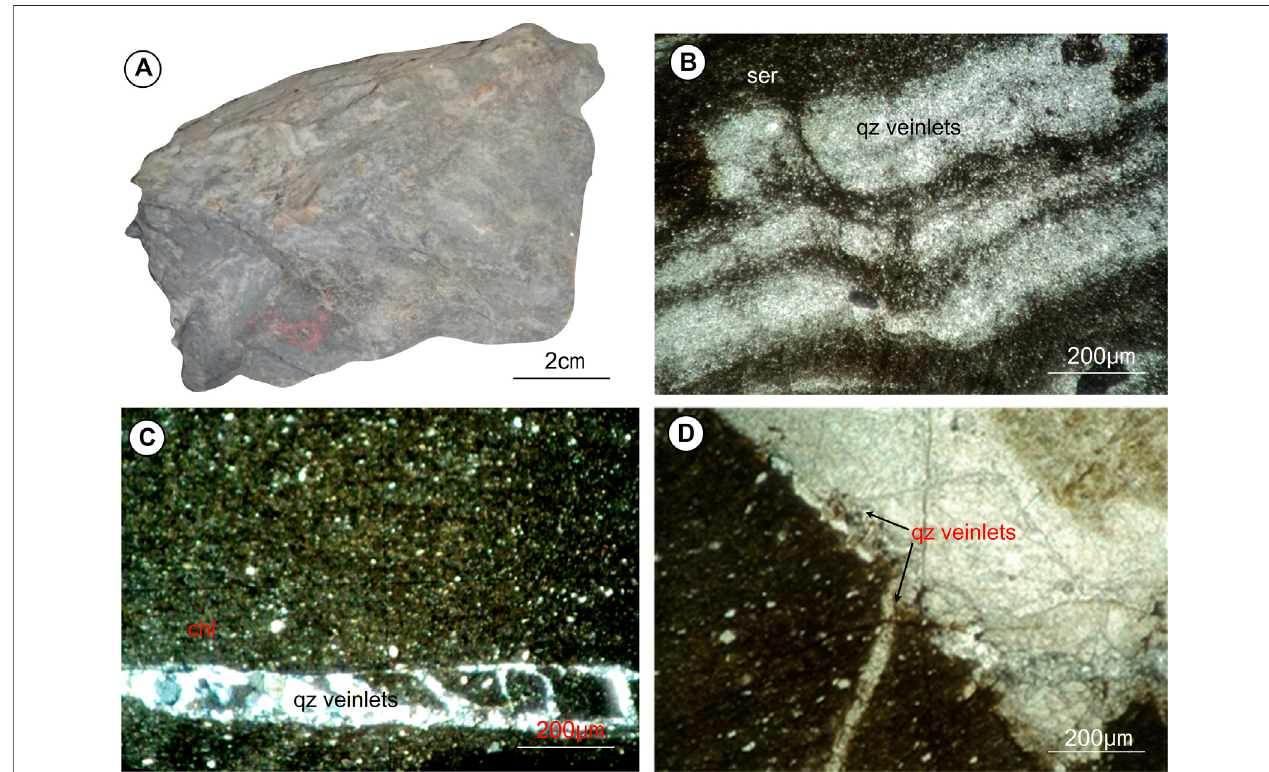
FIGURE8| LithologyandmicroscopicveintextureoftheShwetagungolddeposit. (A) PhotographsshowingslatymudstonehostrockinshearzonefromaditI, (B) Photomicrographs showing ductile structures with sericite alterations in slaty mudstone from adit II, (C) chlorite alterations from adit II and (D) Silici fi cation from adit I. Abbreviations: qz (cid:1) quartz ser (cid:1) sericite and chl (cid:1) chlorite.